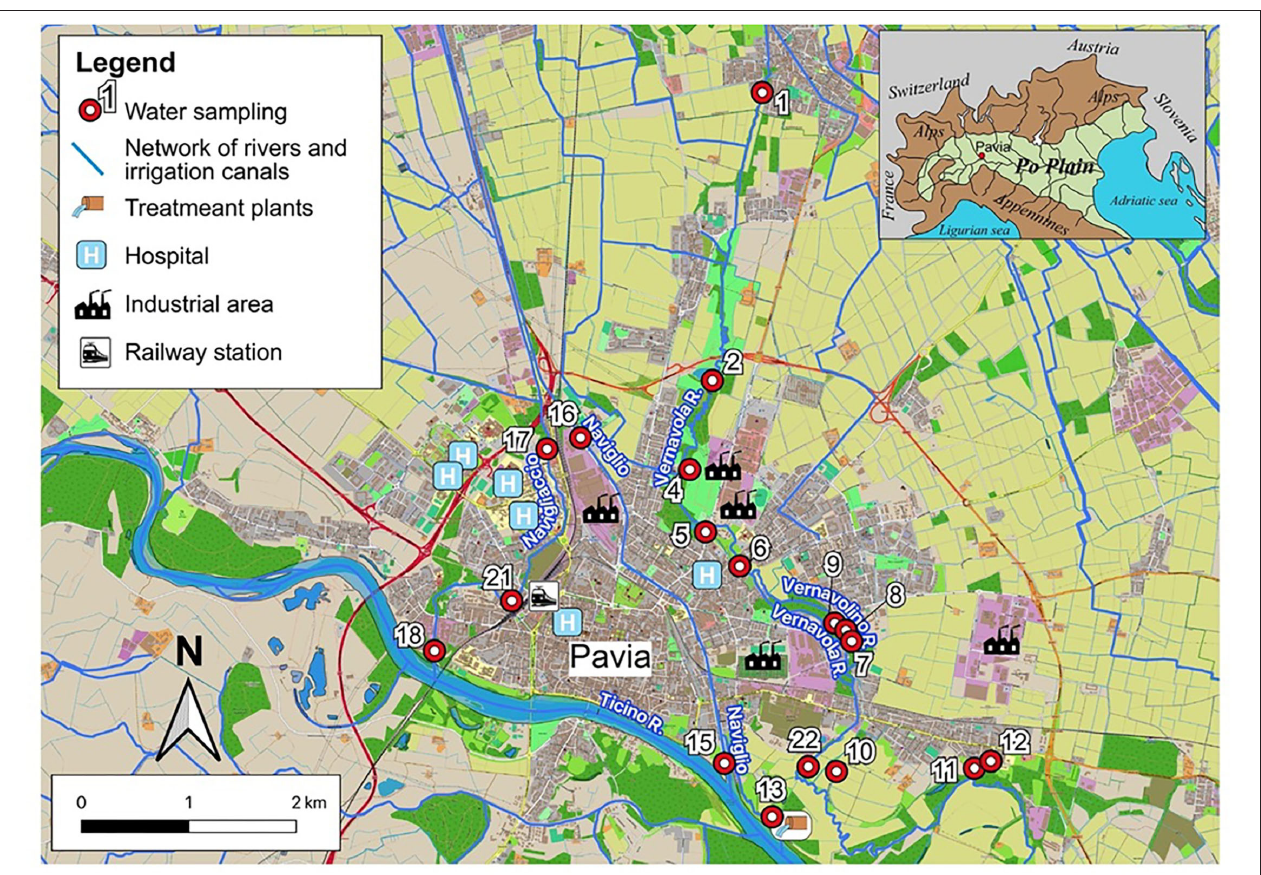
FIGURE 1 | Map of the urban area of Pavia; the watercourses are indicated by names and the sampling sites by